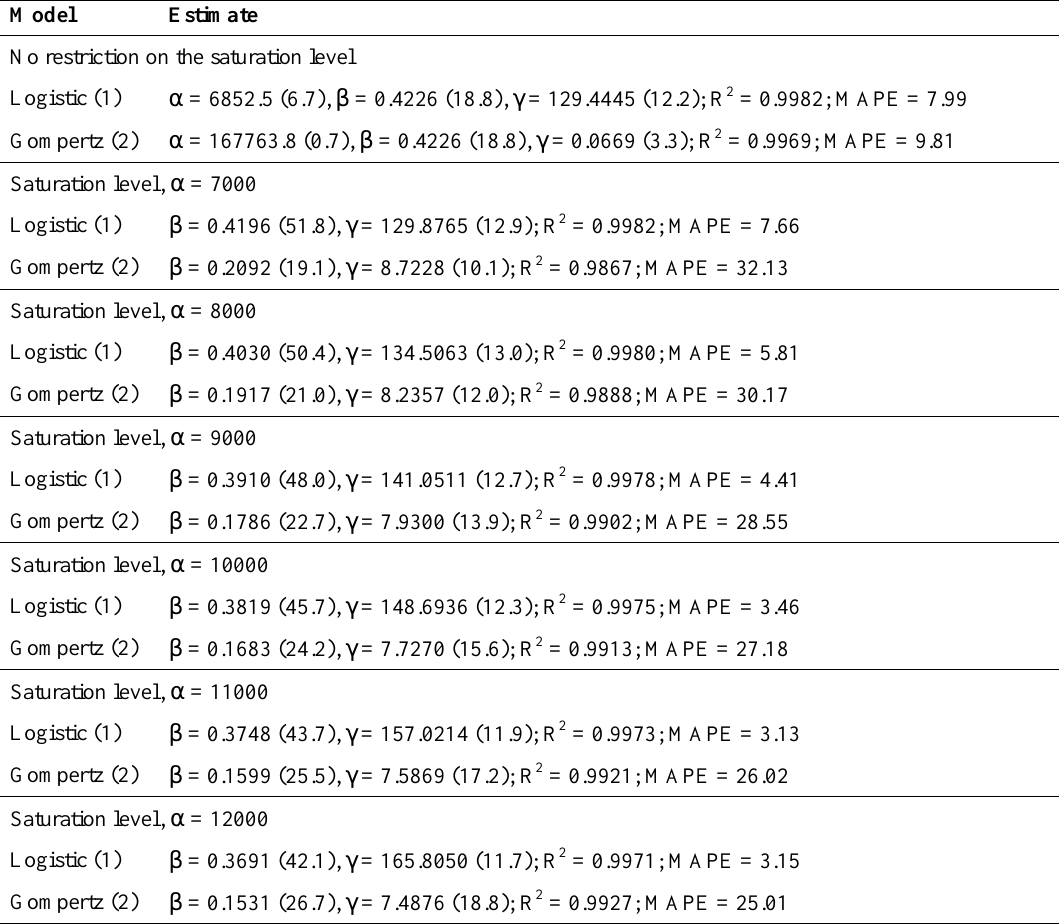
Table 2. Parameter estimates of the logistic and Gompertz models (with t-statistic